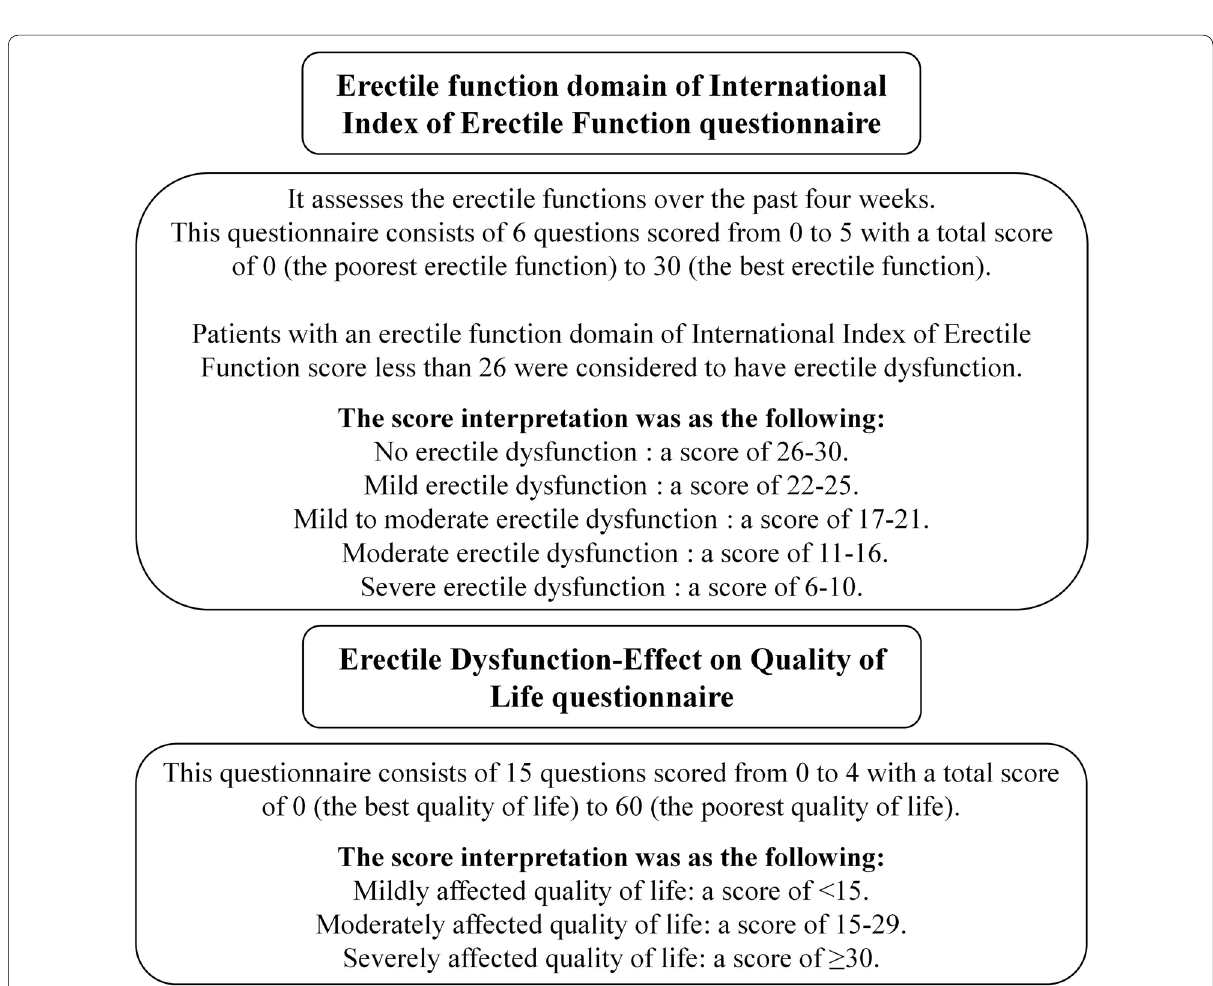
Fig. 2 Illustration of the erectile function domain of International Index of Erectile Function questionnaire and the Erectile Dysfunction-Effect on Quality of Life questionnaire and their interpretation [10,